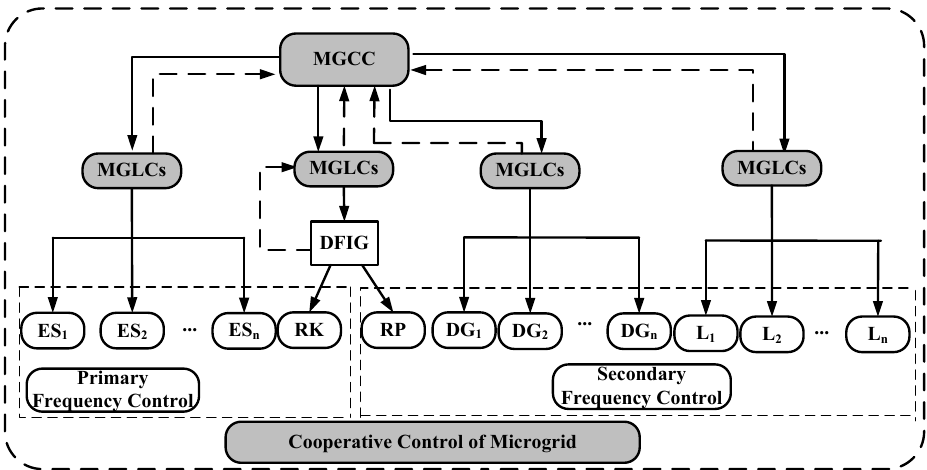
Figure 2. Two layered frequency control